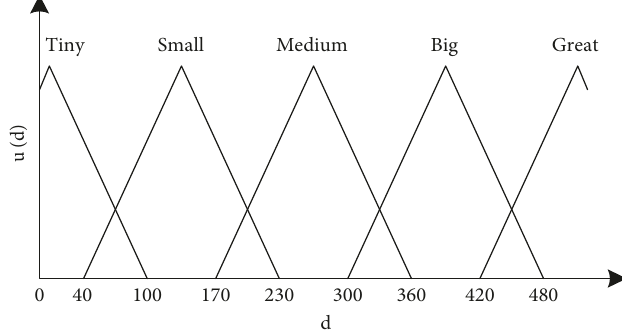
Figure 3: Membership function of the fuzzy subset A